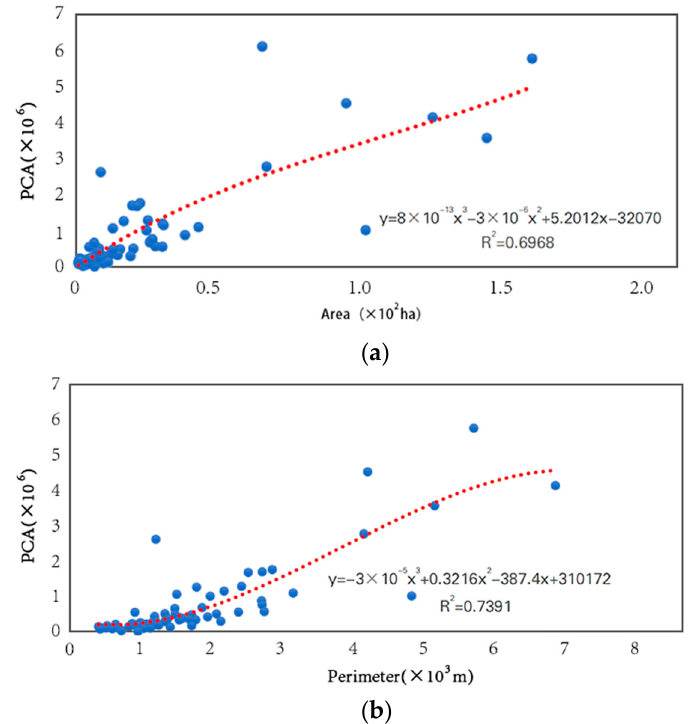
Figure 8. ( a ) Fitted curve of the urban park area and park cooling area; ( b ) fitted curve of the urban park area and perimeter.